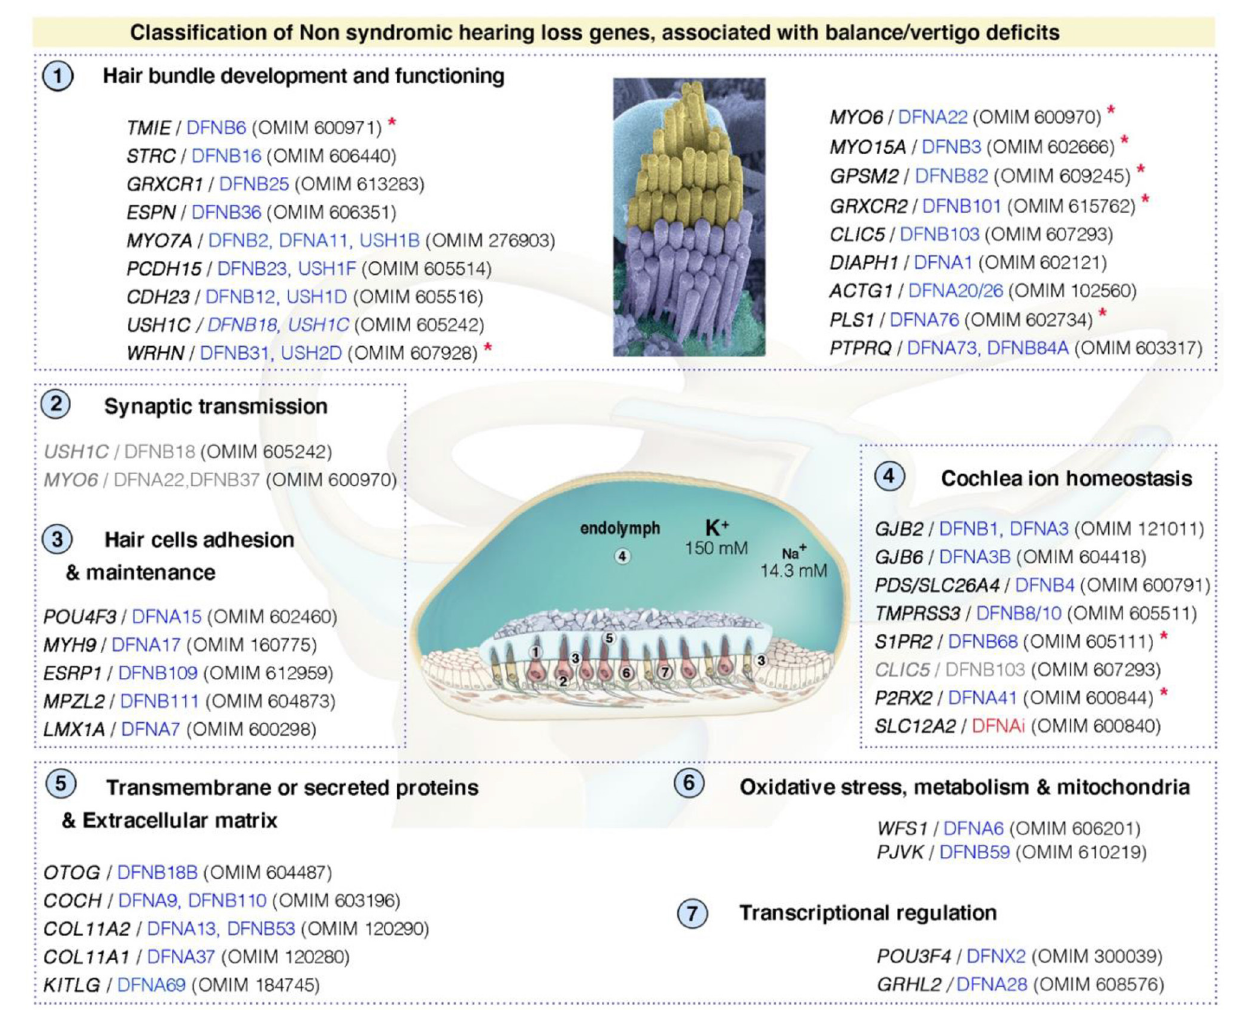
FIGURE 4 | Functional stratification of genes/proteins causing isolated deafness hearing loss, combined with vestibular deficits. Only human genes responsible for non-syndromic deafness, and for which vestibular deficits have been reported based on clinical findings in affected patients (cf. OMIM numbers); and established role and characterization of corresponding animal models, are shown. These can be grouped into several functional categories: (1) hair bundle development and functioning, (2) synaptic transmission, (3) hair cell’s adhesion and maintenance, (4) cochlea ion homeostasis, (5) transmembrane or secreted proteins and extracellular matrix, (6) oxidative stress, metabolism and mitochondrial defects, and (7) transcriptional regulation. DFNAi (red) denotes autosomal-dominant forms of deafness with undefined locus number. The genes/loci in gray denote that they share several functional categories. Similar stratification has been observed for deafness genes (49). Red asterisks indicate those included based on the presence of unambiguous vestibular deficits only in mouse models. More detailed information regarding the deafness causative genes is provided in Supplementary Table S1